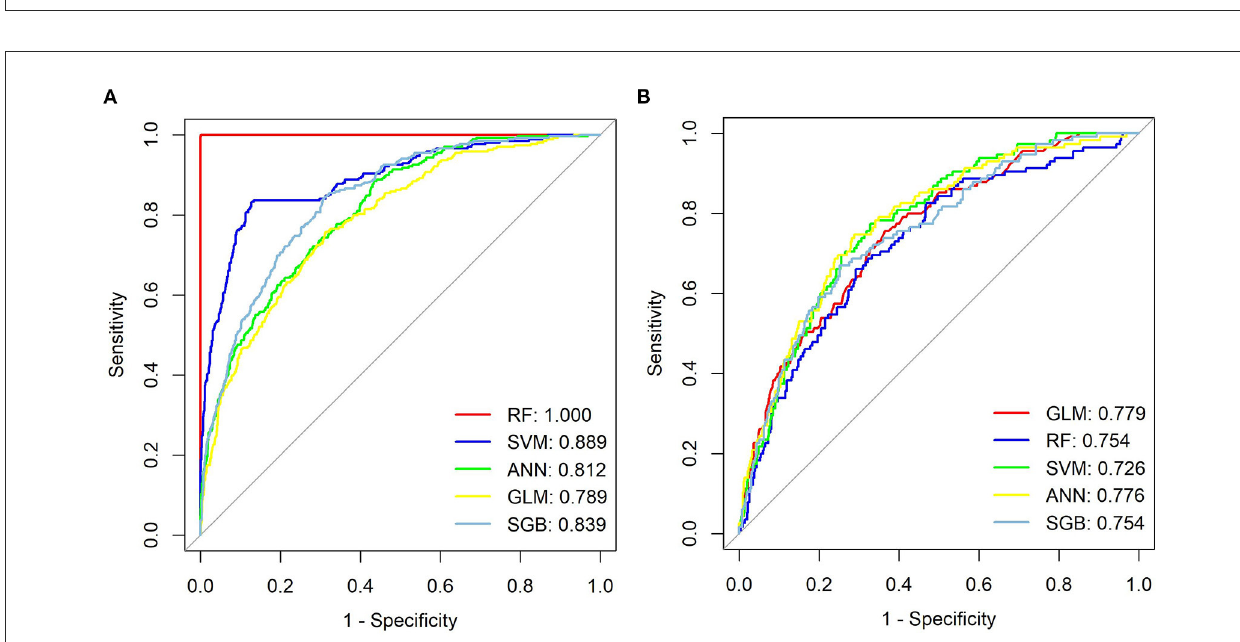
FIGURE3 ROC curves from seven models, training set (A) and test set (B) . GLM, generalized linear model; RF, Random Forest; SVM, support vector machine; ANN, artificial neural network; SGB, Stochastic Gradient Boosting.